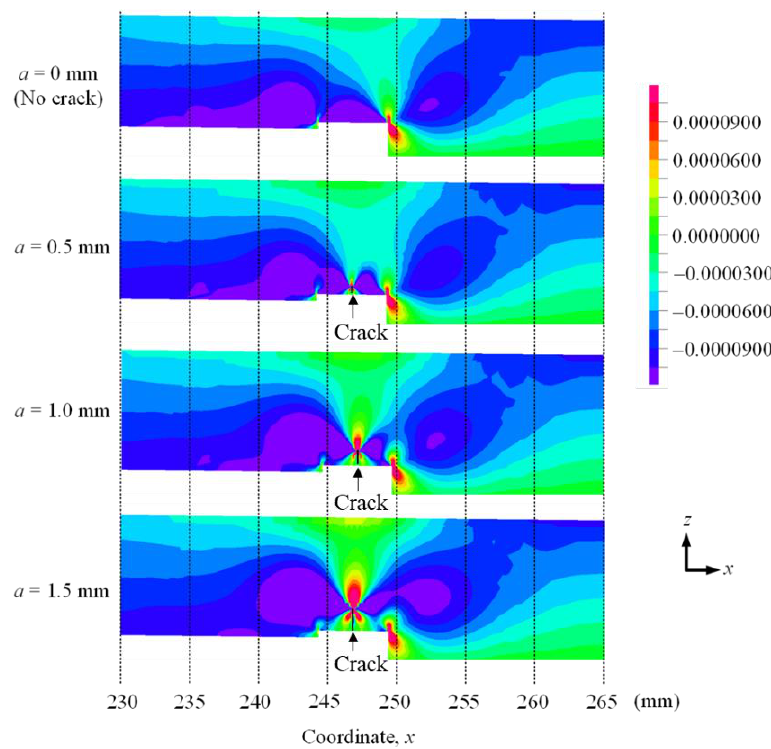
Figure 11. The strain distribution ( ε z ) of Model 2D-TBC, a = 0, 0.5, 1.0, 1.5 mm.